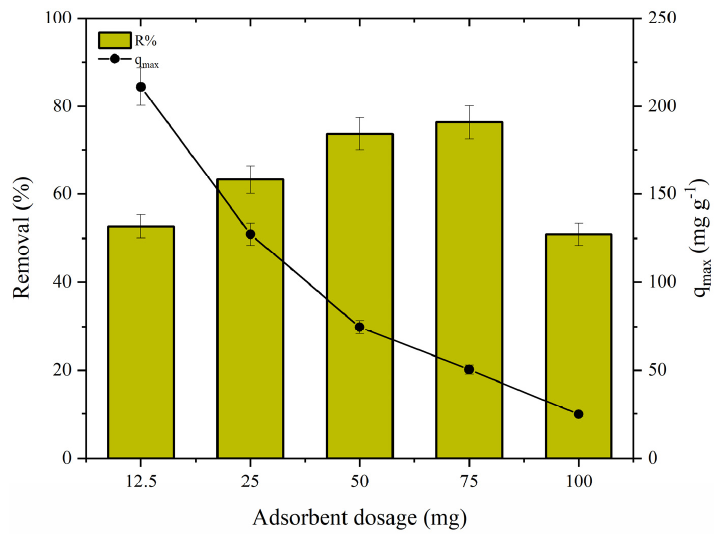
Figure 9. Effect of the adsorbent dosage on TC adsorption (CS · Fe 3 O 4 dosage (0.125–1.0 g L − 1 ), initial Figure 9 . Effect of the adsorbent dosage on TC adsorption (CS·Fe 3 O 4 dosage (0.125–1.0 g L − 1 ), initial concentration of TC (50 mg L − 1 ), pH = 7.0, and 293.15 concentration of TC (50 mg L − 1 ), pH = 7.0, and 293.15 K).